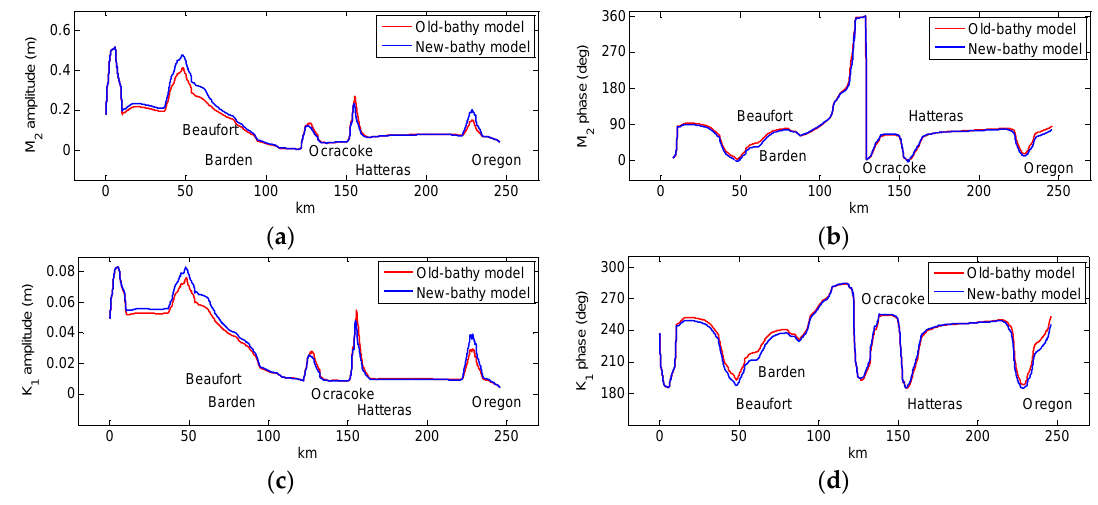
Figure 15. Longitudinal variations of: ( a ) the M 2 amplitude; ( b ) the M 2 phase; ( c ) the K 1 amplitude; ( d ) the K 1 phase along a line (shown in Figure 2b) about 1 km behind the barrier islands. The red lines indicate the results from the old-bathy model. The blues lines indicate the results from the new-bathy model.